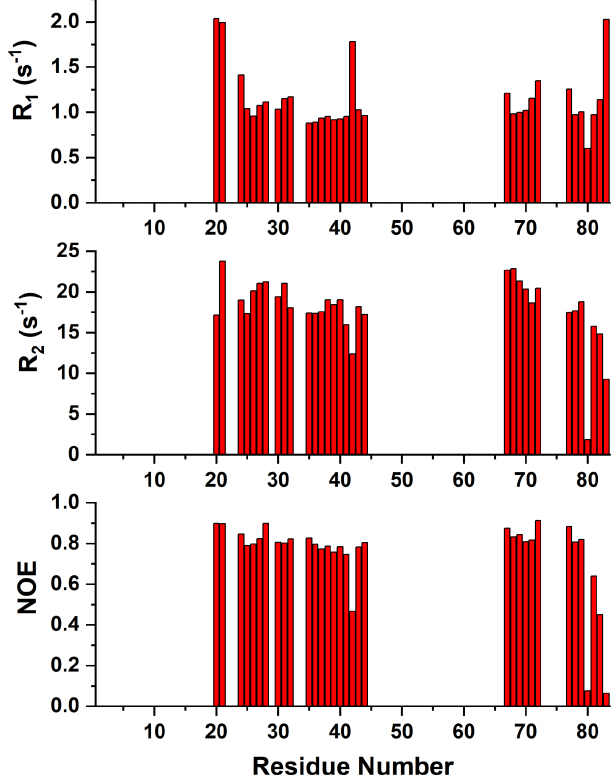
Figure A4. 15 N R 1 , R 2 , and 15 N { 1 H } NOE values versus residue number of reduced mitoNEET obtained at 500MHz and 298K.